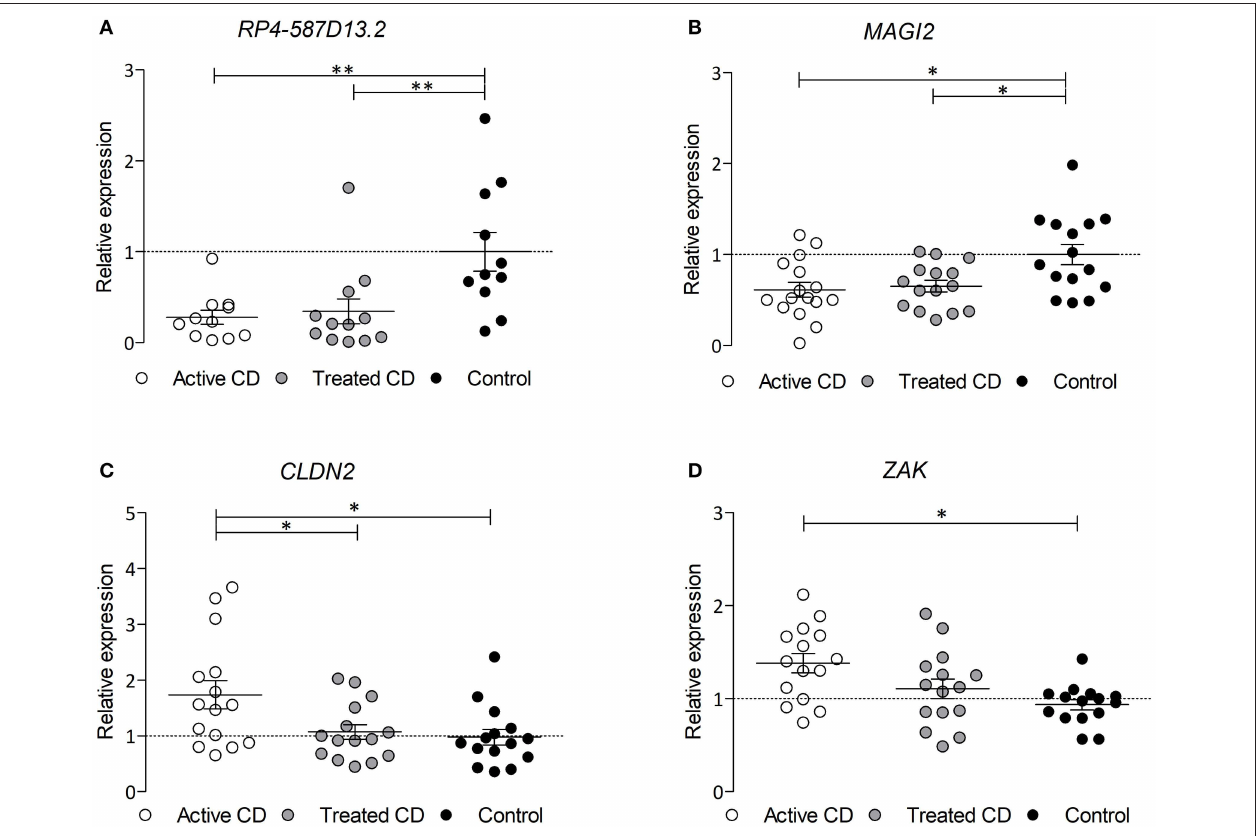
FIGURE 4 | mRNA expression of (A) RPL4-587D13.2 , (B) MAGI2 , (C) CLDN2 , and (D) ZAK in duodenal biopsies from CD patients at diagnosis (white dots), treated CD patients (gray dots) and non-Celiac controls (black dots) represented as mean and SEM, relative to the average of the control samples (*0.01 < p < 0.05; **0.001 < p <